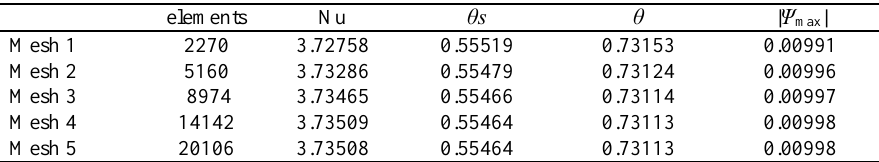
Table 2. Mesh independence test